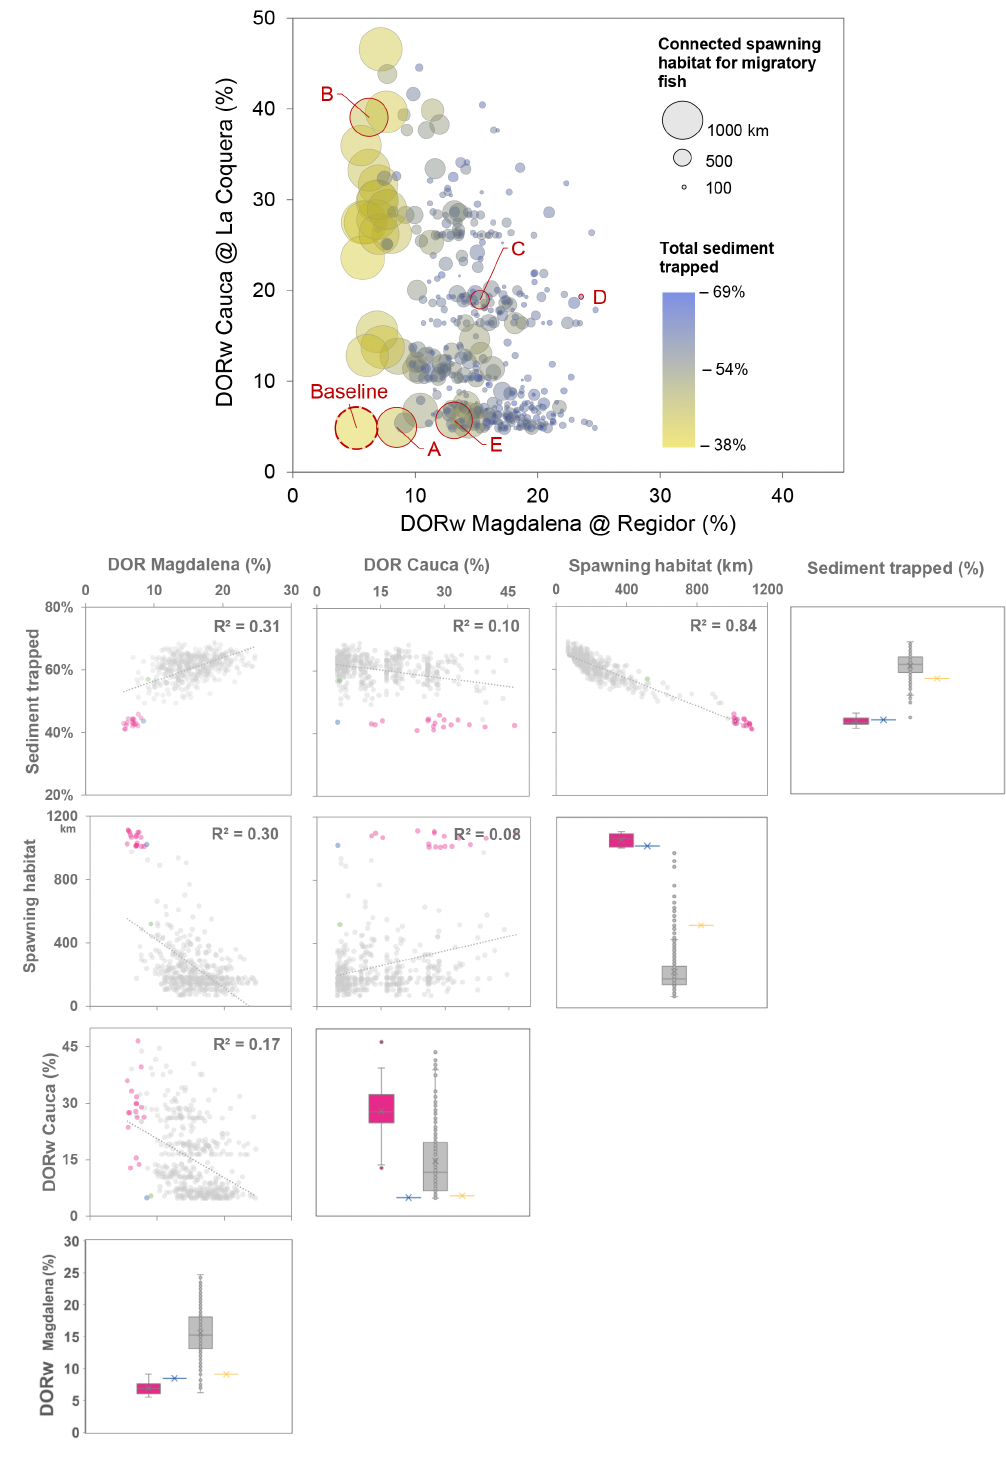
Figure 9. Trade-off plot for scenarios in the range of expected hydropower expansion (15250 ± 500MW). Top panel: x and y axes are expected DOR w upstream of the Mompós Depression on the Magdalena and the Cauca, respectively; bubble size represents length of connected network in the range of 400–1000ma.s.l. (spawning habitat), and color indicates the expected loss of sediment load due to reservoir trapping. Selected scenarios for detailed analyses are labeled as A–E. Bottom panels: 2-D plots and box-plots of individual metrics of basin-level impacts. Colors identify different sampling strategies following legend shown in Fig.